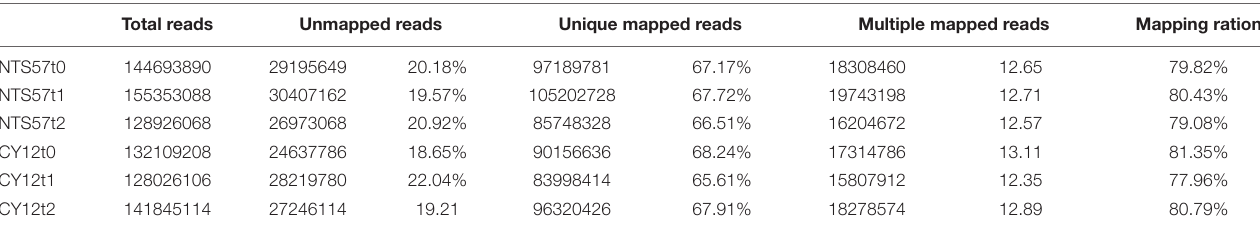
FIGURE 2 | Distribution of the putative QTLs for flowering time on the genetic map. Strips represent QTLs detected, and their location and length represent their location of QTL on the linkage map and interval span. The scale represents the genetic distance (cM). TABLE 4 | Summary of the read numbers from the RNA-seq data for the four